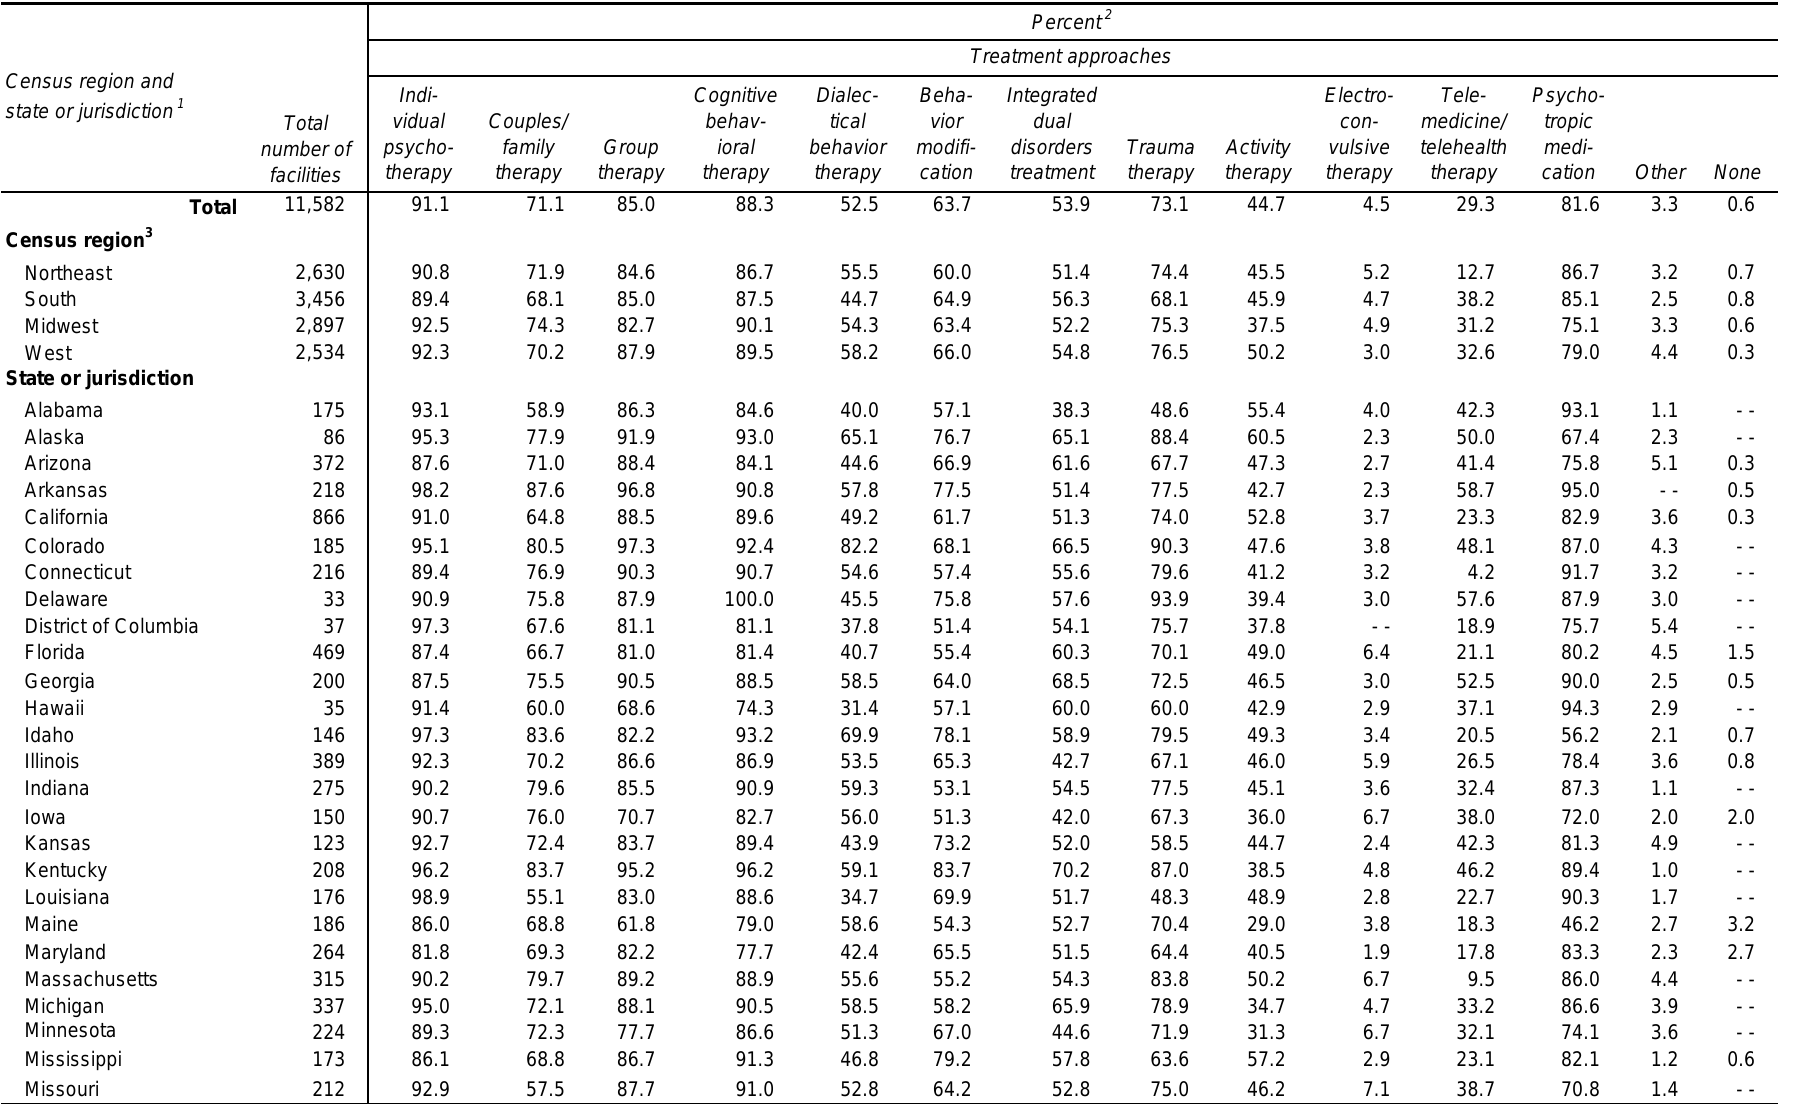
Table 3.7b. Treatment approaches offered, by Census region and state or jurisdiction: Percent,